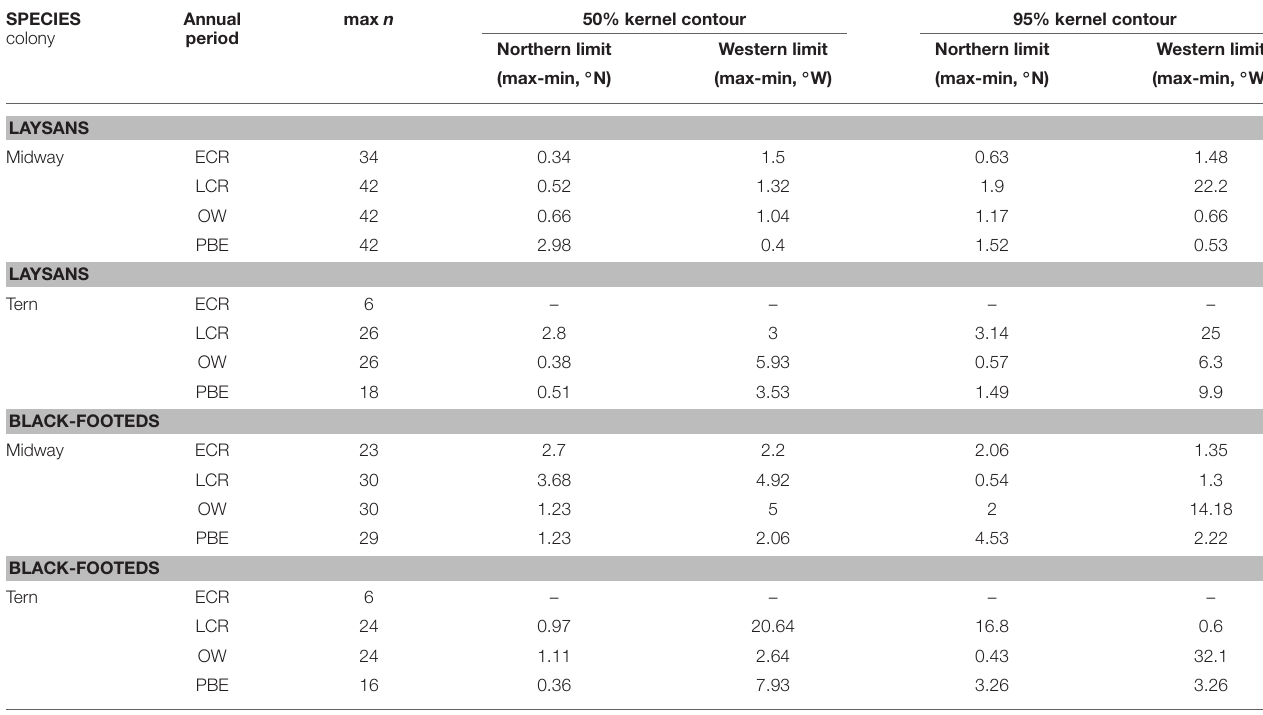
TABLE 4 | Range in 50 and 95% contour locations from KDE successively removing one